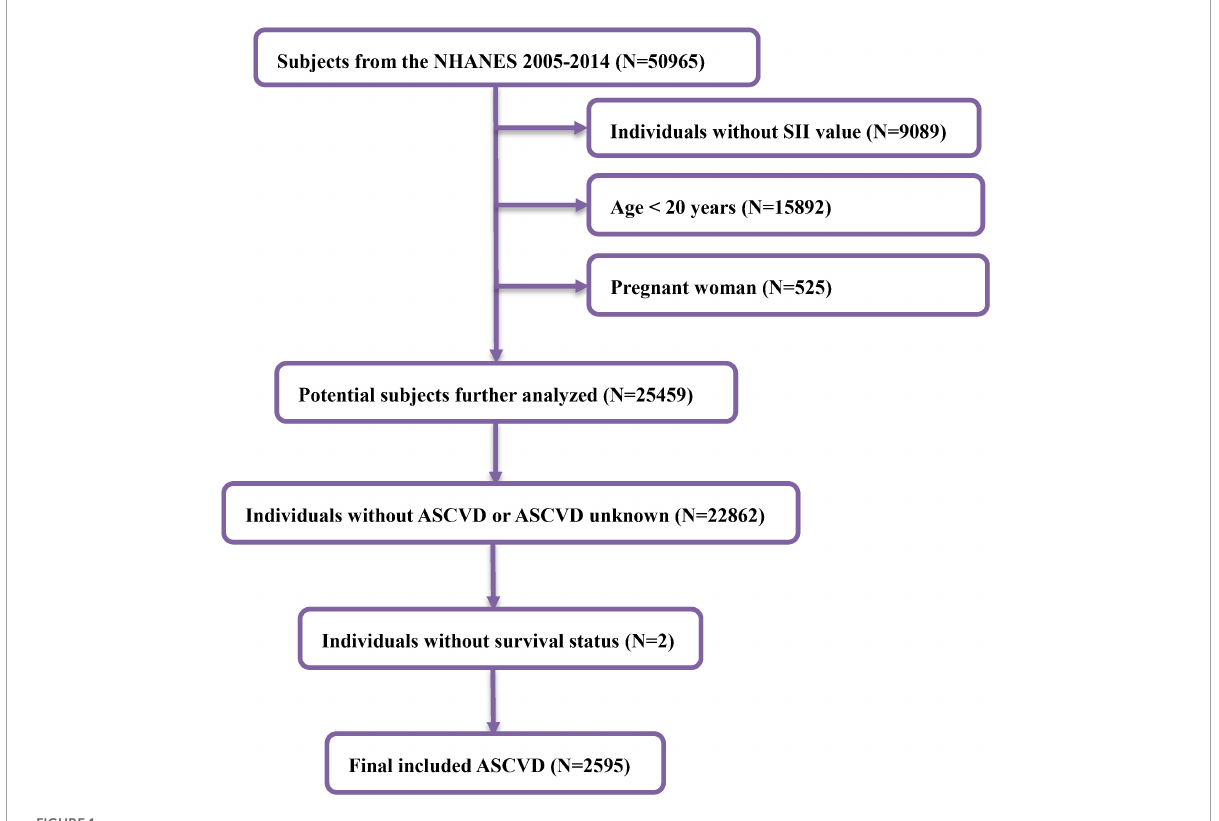
FIGURE1 Flowchart diagram of patients’ selection in this